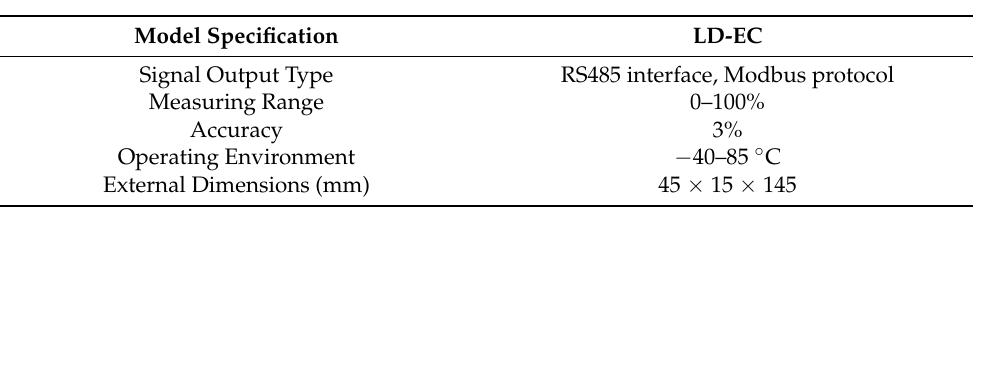
Table 2. Technical parameters of the soil moisture